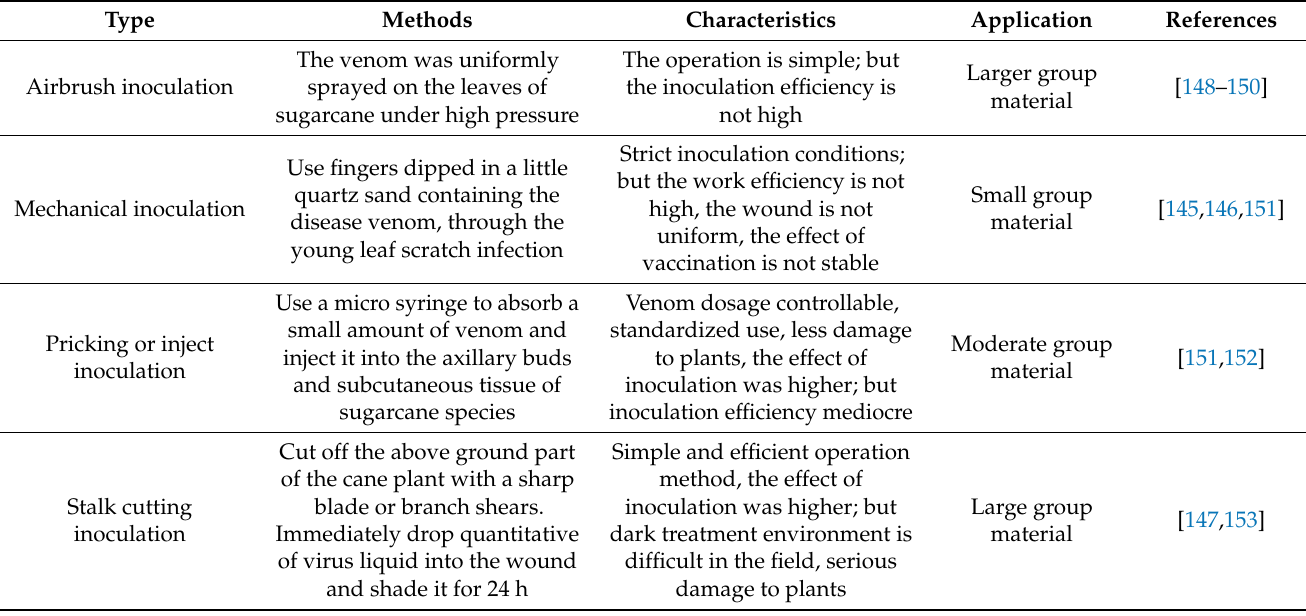
Table 4. Comparison of artificial inoculation methods for mosaic resistance